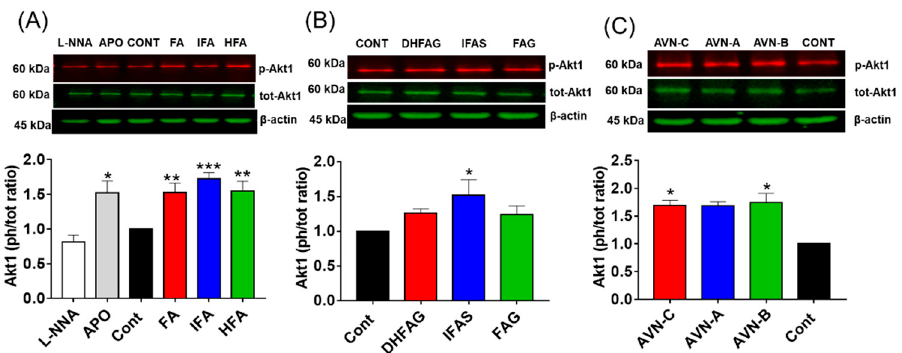
Figure 5. Akt1 activation state, measured as phosphorylation (Ser 473)/total ratio in HUVEC pre- treated for 2 h with the un-conjugated oat phenolics ( A ), sulfate and glucuronide metabolites ( B ) and avenanthramides ( C ) at physiologically relevant concentration (1 µ M). Controls (CON) Ferulic acid (FA) isoferulic acid (IFA), dihydroferulic acid (DHFA), FA glucuronide (FAG), DHFA glucuronide (DHFAG), IFA sulfate (IFAS), avenanthramide A (AVN-A) avenanthramide B (AVN-B) avenan- thramide C (AVN-C) were tested. Apocynin (APO, 100 µ M) and L-NG-Nitro-Arginine (L-NNA, 100 µ M) were used as additional controls ( A ). Data with error bars represent the average ± SEM of 6 independent experiments and are expressed as phospho-Akt1/ total-Akt1 ratio. * = p < 0.05, ** = p < 0.01, *** = p < 0.001 vs. control ( n = 6) .